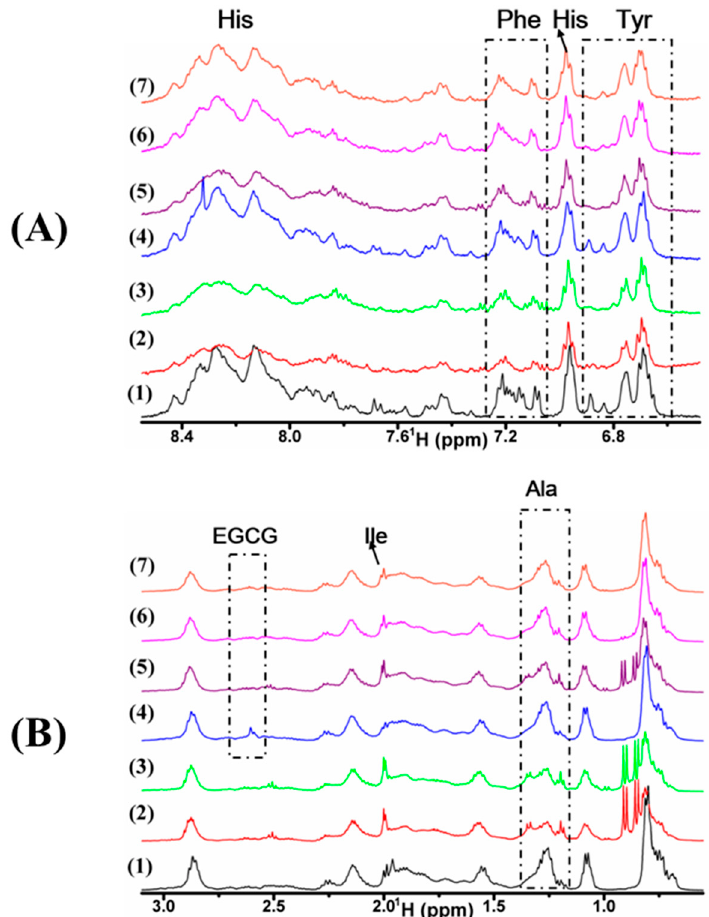
Figure 5. 1 H-NMR of α -Syn treated with Cu(II), EGCG, or their mixture. ( A ) The aromatic region of α -Syn within 6.55 and 8.65 ppm; ( B ) high field region of α -Syn and EGCG within 0.55 and 3.15 ppm. Samples are 50 μ M α -Syn incubated for 0 h (1) and 29 h (2) alone, in the presence of 40 μ M Cu(II) (3), 20 μ M EGCG (4), the mixture of 10 (5), 20 (6), 40 (7) μ M Cu(II) with 20 μ M EGCG, respectively, for 58 h in PBS buffer (20 mM, pH 7.4).